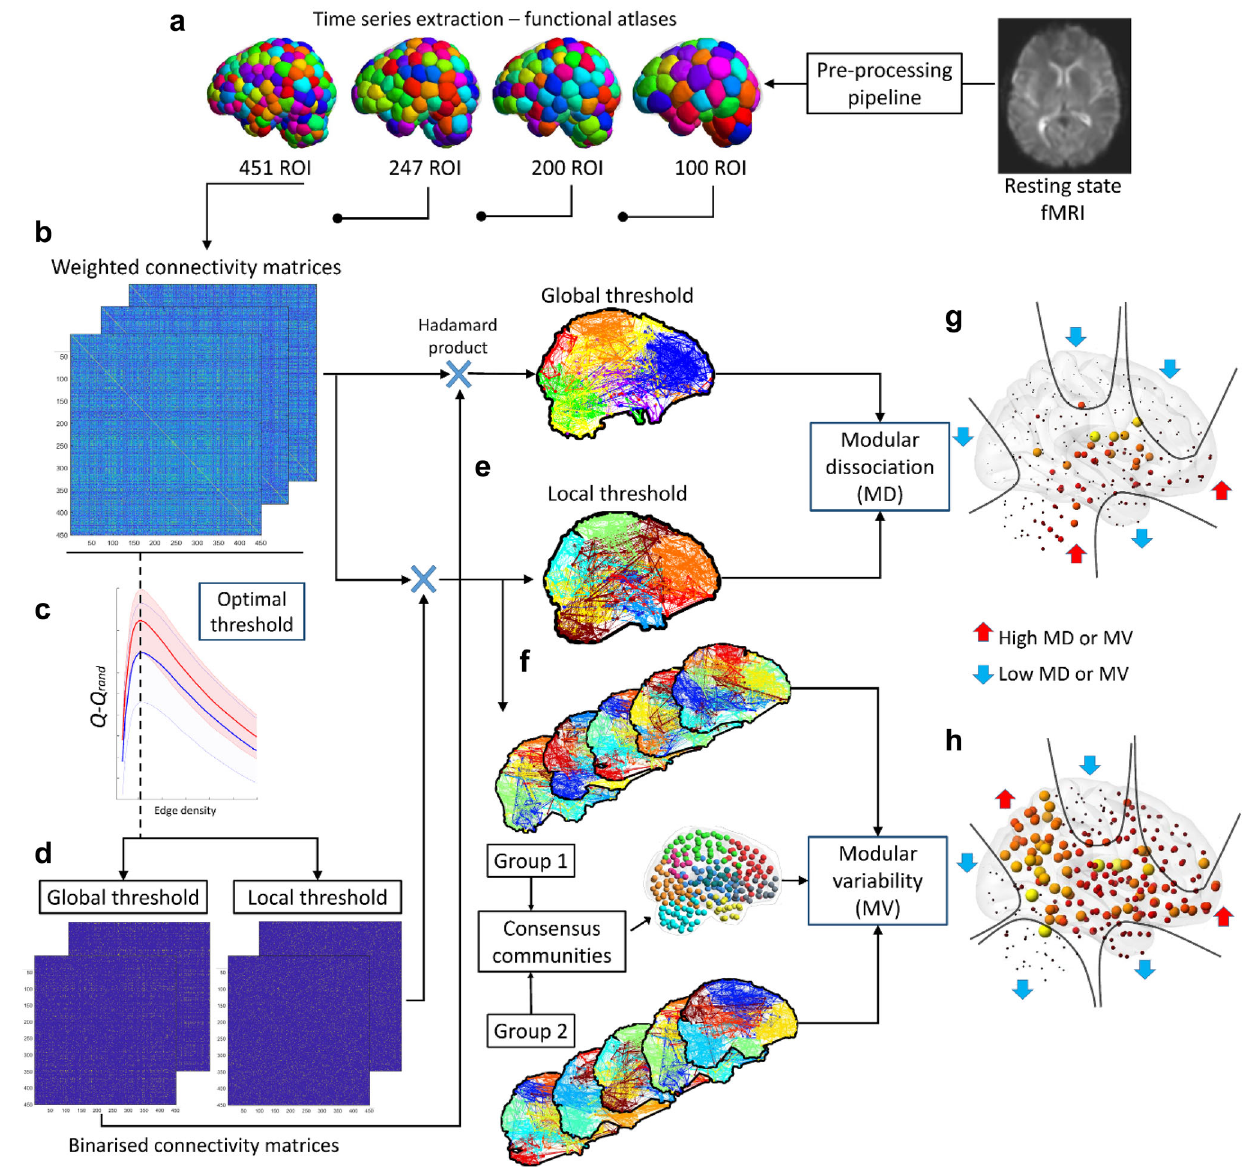
Fig. 1 Methods for modular variability (MV) and modular dissociation (MD). a Resting-state functional MRI pre-processing pipeline and time-series extraction from functional atlases. b Pearson correlation matrices. c Optimal local threshold estimation; the network edge density at which Q − Q rand is maximum. d Thresholded matrices by optimal density using local and global threshold network construction methods. e Louvain ’ s community and modular dissociation (MD) estimation, see also Supplementary Fig 1. f Modular variability (MV) using consensus community. g Group means MD; subcortical regions and cerebellum showed in all groups high MD while motor-sensory, frontal, temporal pole and occipital cortex show low MD. h Group mean MV; patterns of high and low MV were consistent across all groups. Motor-sensory, occipital, and temporal pole showed low MV while parietal, ventral frontal and insulo-opercular cortices showed high